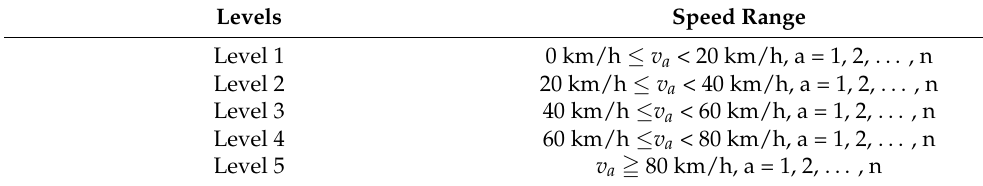
Table 2. Levels of speed